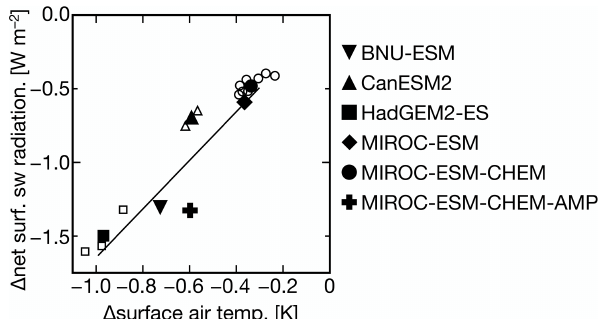
Figure 3. Relationship between the difference in the globally and temporally averaged surface air temperature ( x axis) and that of the net shortwave radiation at the surface ( y axis). The term of average is from 2040 to 2069. For CanESM2, HadGEM2-ES, and MIROC- ESM-CHEM, the ensemble mean is shown by filled symbols and the each member by unfilled ones. The regression line is for the filled symbols of the six